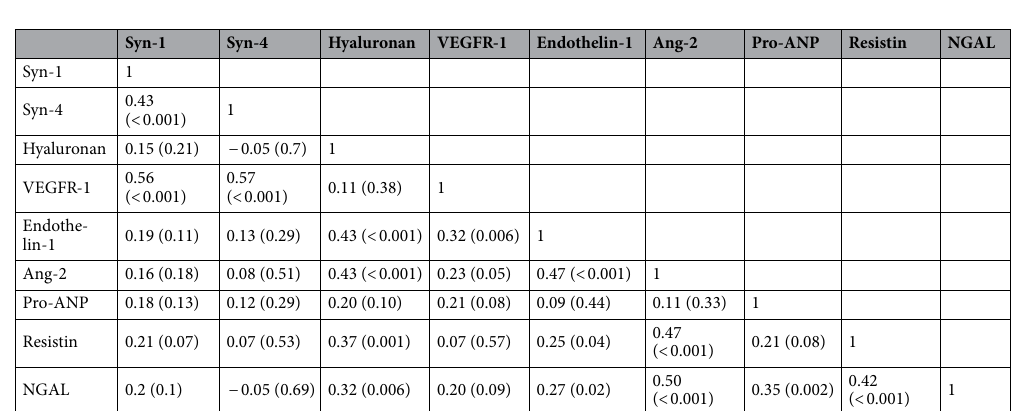
Table 3. Correlations between biomarkers at T24. Spearman’s Rho (p). Syn Syndecan, VEGFR Vascular Endothelial Growth Factor, Ang, ANP Atrial Natriuretic Peptide, NGAL Neutrophil Gelatinase Associated